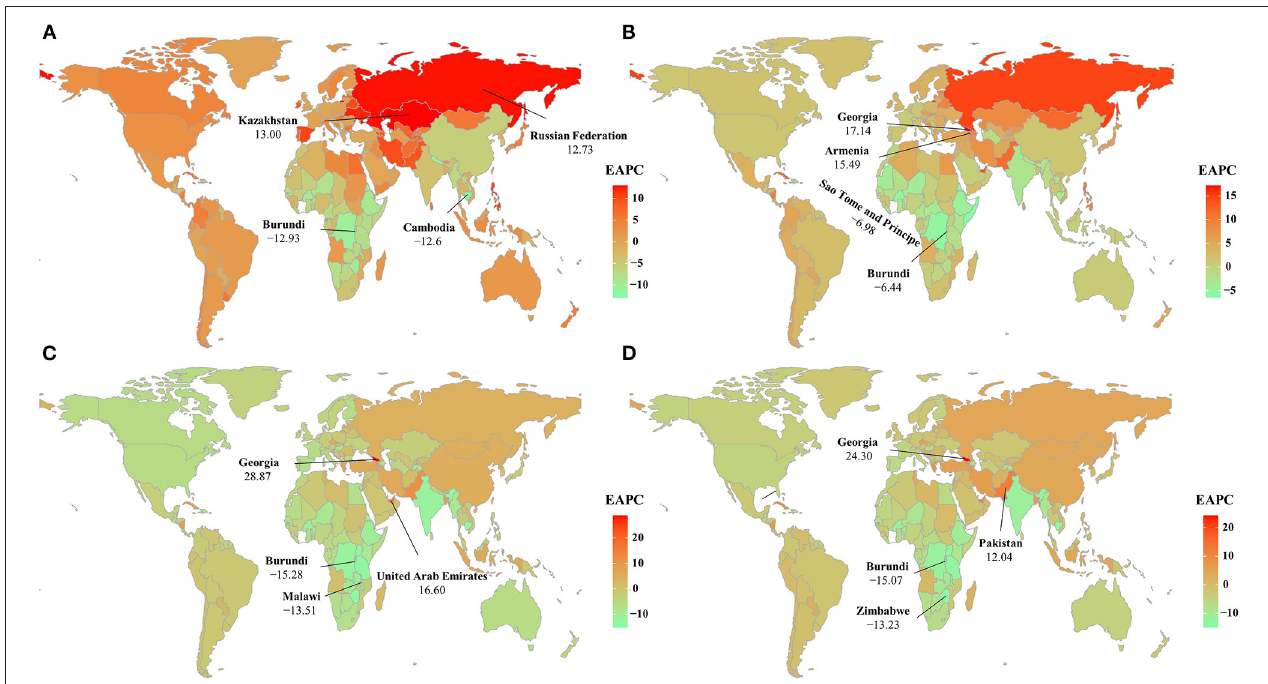
FIGURE 3 | The distribution of the EAPCs of HIV/AIDS burden at the national level during the period 2005–2019, including incidence (A) , prevalence (B) , death (C) , and DALYs (D) . Countries/territories with extreme values are annotated. ASR, age-standardized rate; EAPC, estimated annual percentage change; DALYs, disability-adjusted life